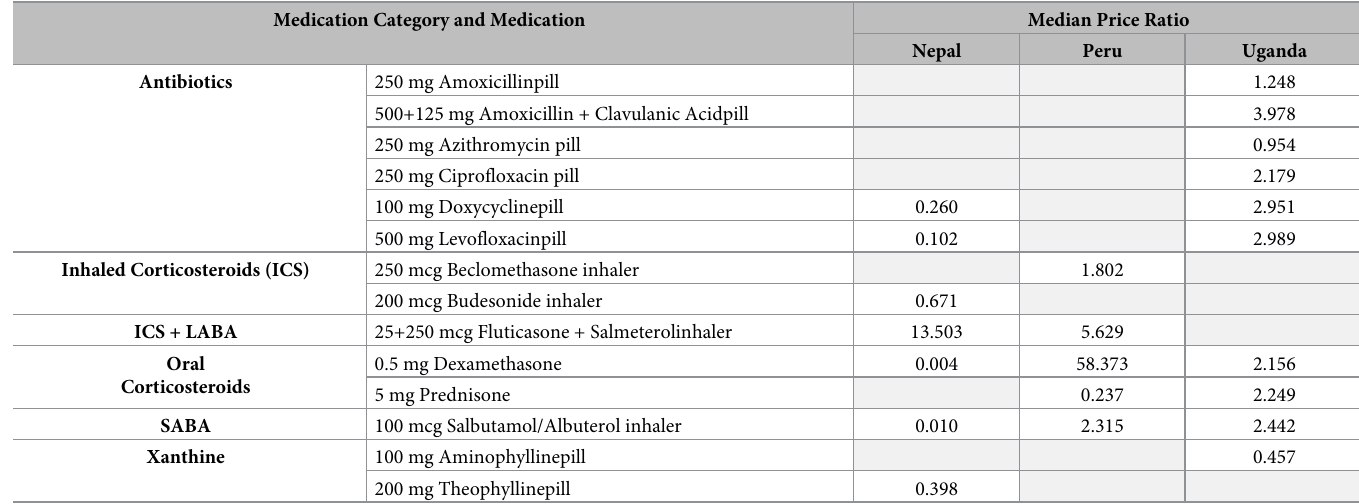
Table 3. Medication Median Price Ratio (MPR).